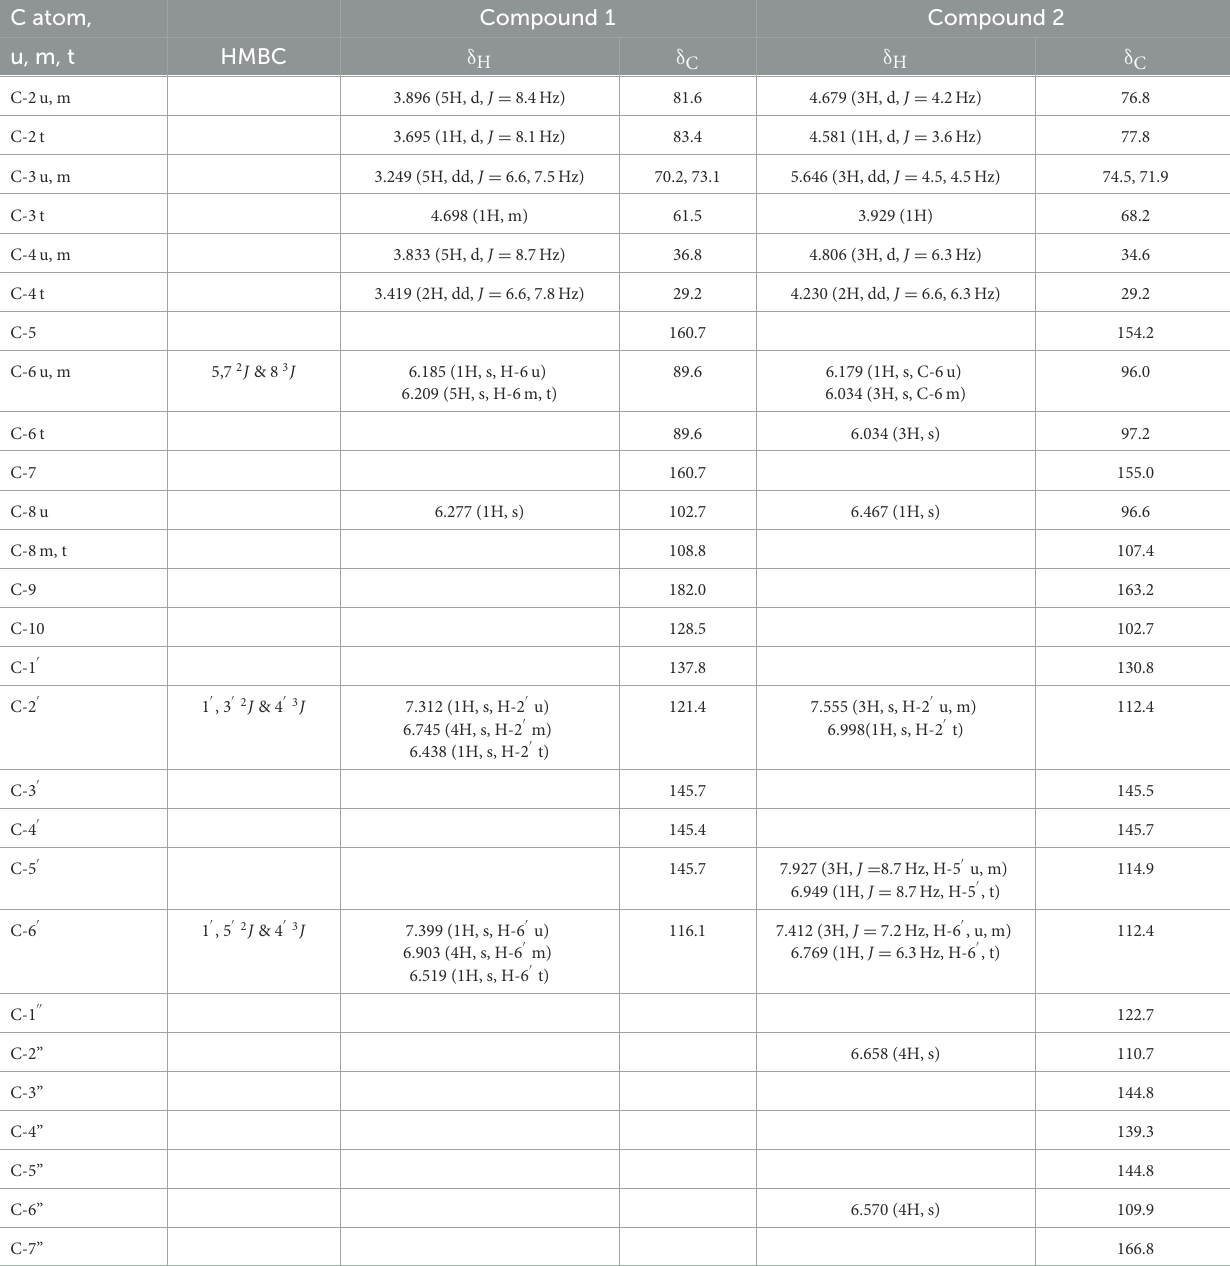
TABLE 1 1 H NMR, 13 C NMR, and HMBC spectral data for compounds 1 and 2 in DMSO-d 6 ( δ , ppm, J/Hz) ∗